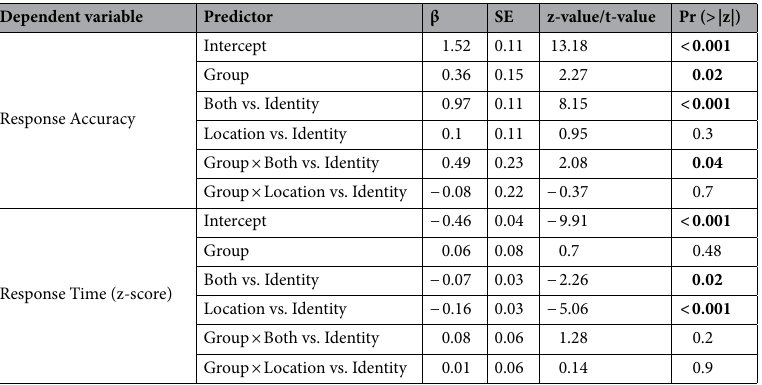
Table 2. Generalized and linear mixed effects model output for the manual responses of recognition accuracy (correct vs. incorrect trials) and response time (correct trials only). Predictors centred and standardized entered in the G(L)MER were: Group (Older = − 0.5 and Younger = 0.5) and Type of Change (Location, Both— Identity as reference level). We report the β , the standard error, the t -value, and the p -value. The random effects introduced as intercepts were Participants (50) and the unique identifier of Scene item